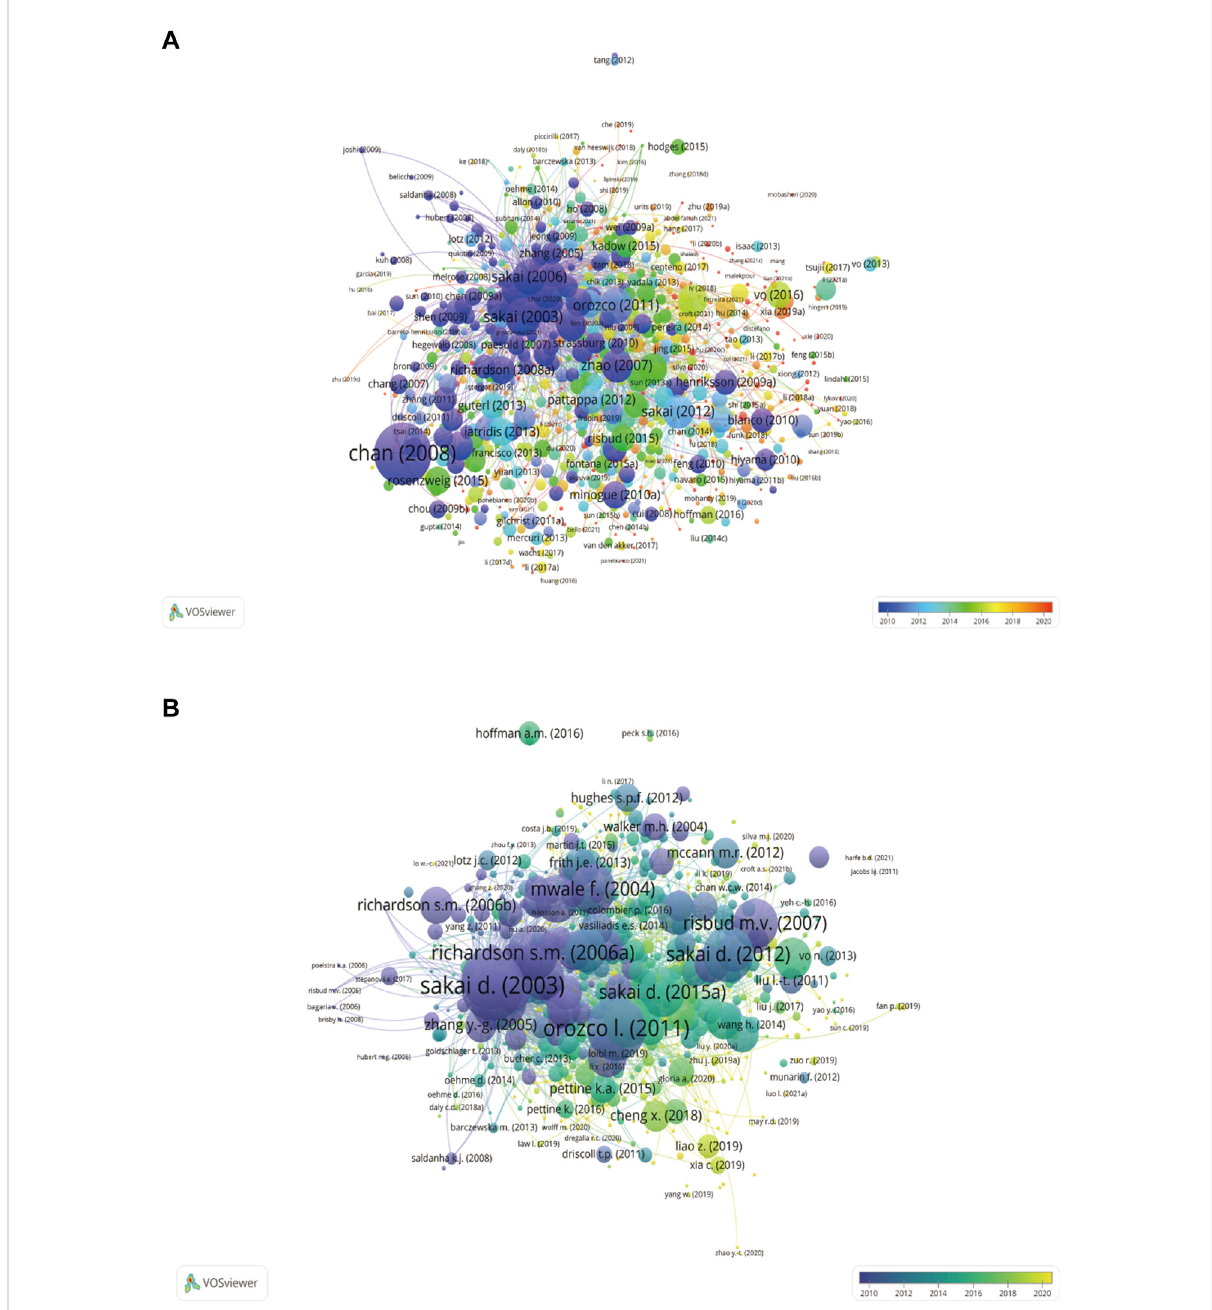
FIGURE 7 OverlayvisualizationplotsofcitedliteratureinWOSCC (A) andScopus (B) .Thedifferentpointsrepresenteddifferentdocuments,whichformed acomplexnetworkbetweenthem.Themorefrequentlyciteddocumentswererepresentedaslargerpointsinthegraph.Thedifferentcoloursofthe dots represented different publication periods. For example, in WOSCC, chan (2008) was the largest point, indicating that it was the most cited document, while its blue colour indicated that it was published earlier in the whole network. What ’ s more, in Scopus, cheng x (2018) was the brighter point, indicating that it was published